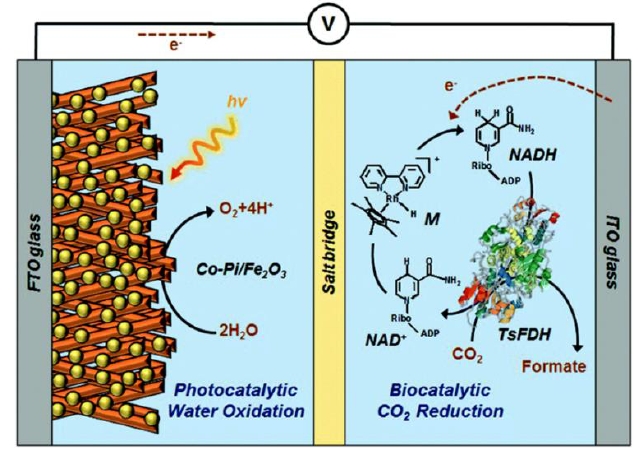
Figure 8. Schematic illustration of the biocatalytic PEC platform [131].